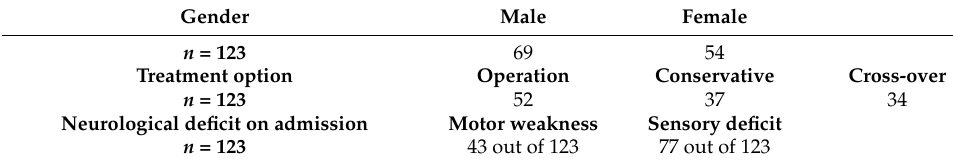
Table 2. Categorical patient data on